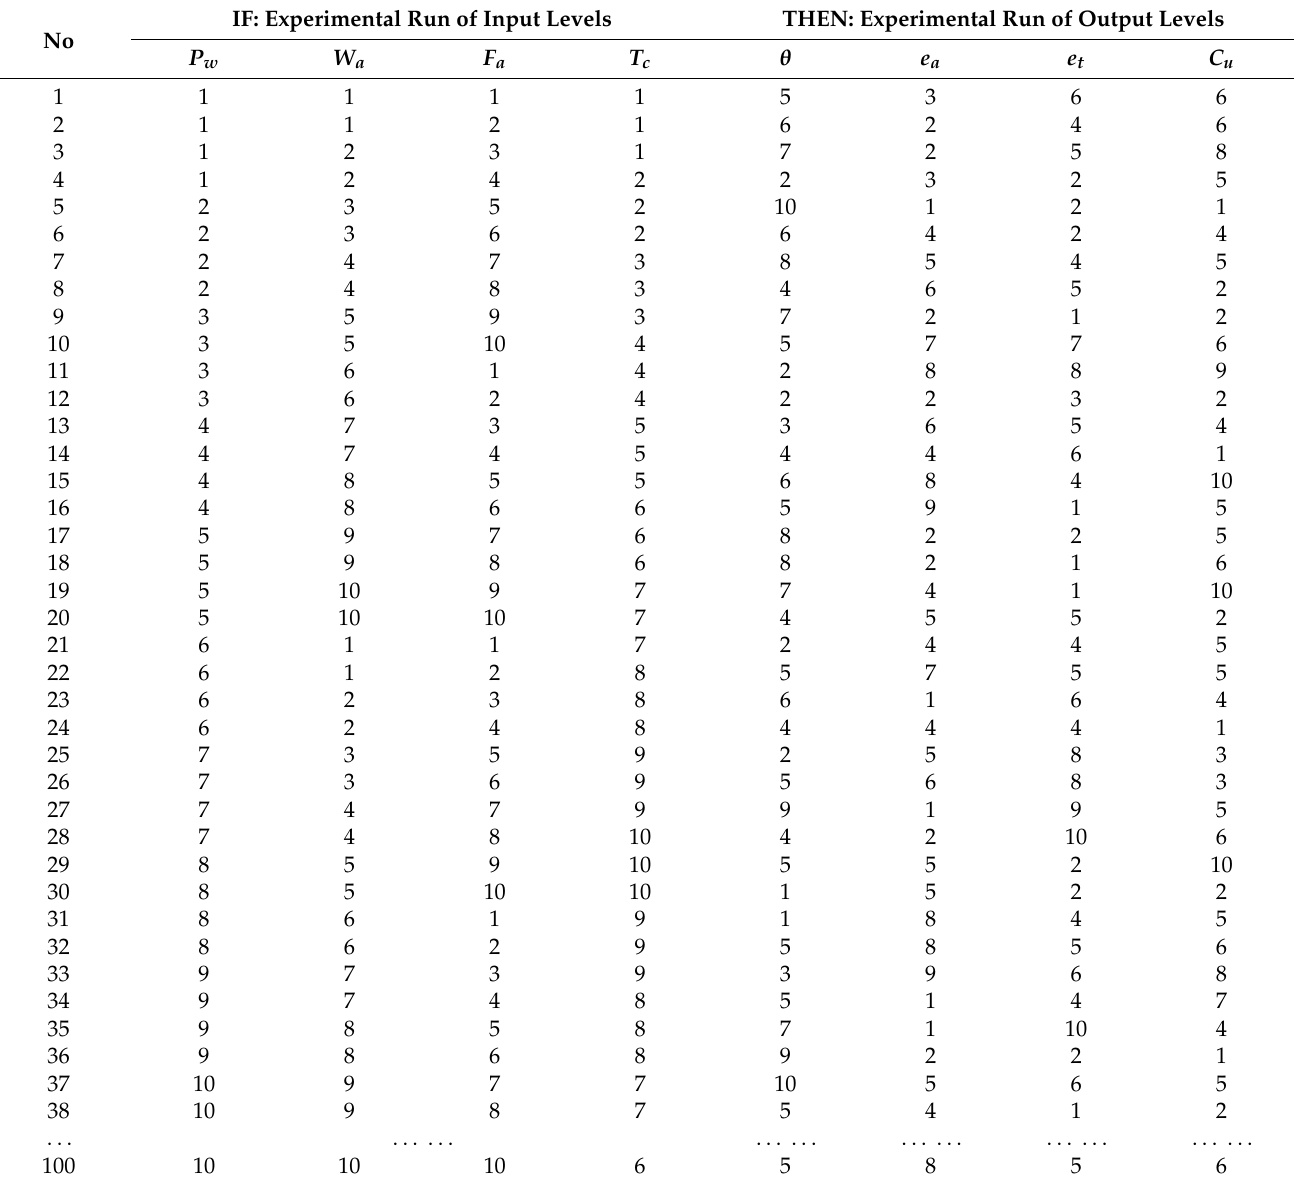
Table 3. Logic rules of RSAE–ANFIS system. The partitioned levels of irrigation parameters, such as jetting pressure ( P w /kPa), impinge angle ( W a / ◦ ), flow rate of water ( F a /kg/min), and continuous irrigation time ( T c /min), are input variables. The partitioned levels of infiltration effectiveness indexes, including average soil moisture depth increment ( θ /mm), irrigation infiltration efficiency ( e a /%), irrigation turn duration efficiency ( e t /mm/min), and the uniformity coefficient of soil moisture infiltration ( C u /%), are output